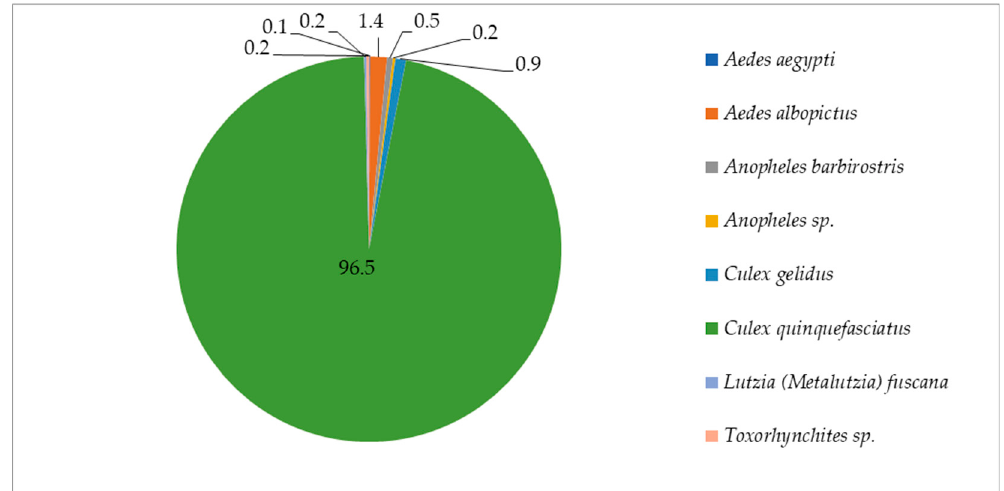
Figure 3. Monthly environmental parameters (mean temperature, relative humidity, and total rain- fall) for study area.